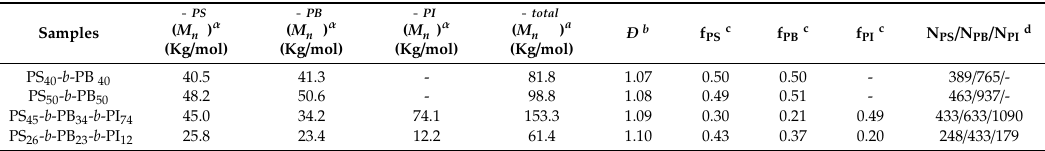
Table 1. Molecular characteristics of diblock copolymers and triblock copolymers that were used as block copolymer (BCPs)